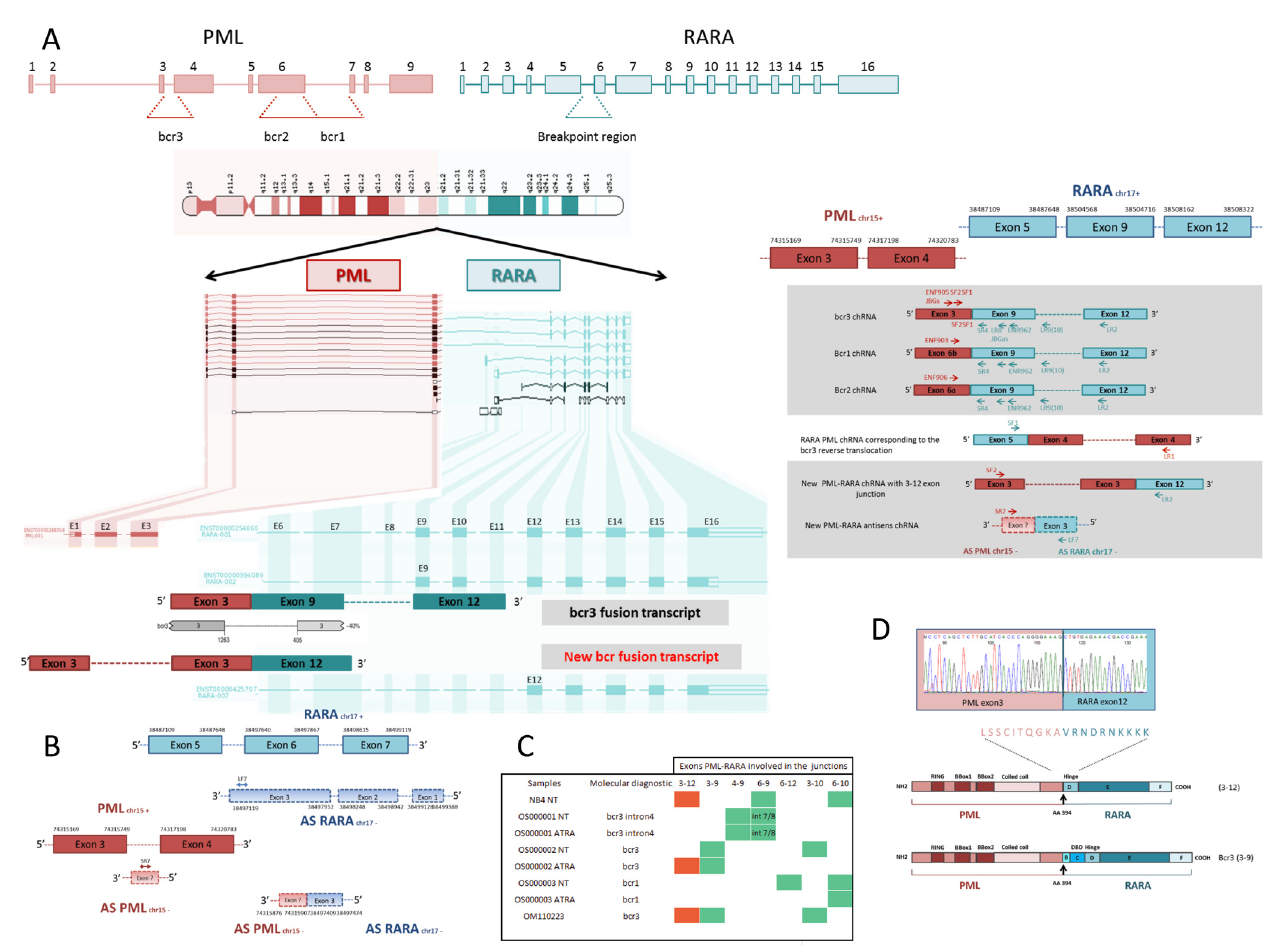
Figure 3. Identification of new PML-RARA fusion transcripts. ( A ) Scheme of PML and RARA genes are shown on the top, with the potential breakpoints. Below is the schematic of the chromosomal translocation, with visualization of the short bcr3 fusion transcript. Gene structures for both PML and RARA genes (ENSEMBL genome browser), and exons involved in new PML-RARA chimera are shown. We assigned a number to exons ( E ) of each gene. Bcr3 fusions found in this study are shown below, including the newly found fusion between exon 3 of PML and exon 12 of RARA. ( B ) New RARA-PML antisense fusion transcript. Schematic of RARA (blue) and PML (red) antisense transcript positions relative to their sense transcript, and the resulting antisense fusion transcript, are shown below. ( C ) Identification of selected PML- RARA transcript junctions in acute promyelocytic leukemia samples and NB4 cells by qPCR. ( D ) Hypothetical incidence of PML-RARA fusion transcript on protein domains. Sanger sequencing results of the 3-12 PML-RARA fusion is shown on the top. The hypothetical protein